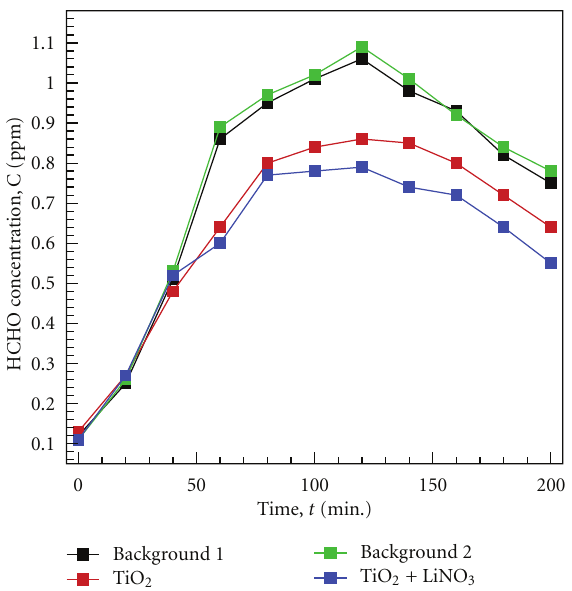
Figure 10: The degradation performance for gaseous formaldehyde under irradiation of UVA lamps at 26 ◦ C.